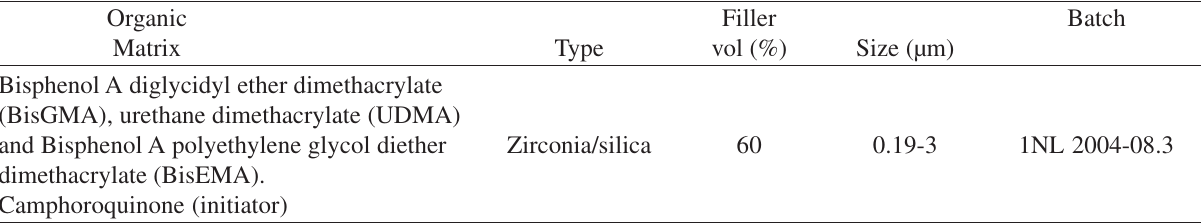
Table 1. Composition of organic matrix and filler of the Z250 composite resin.